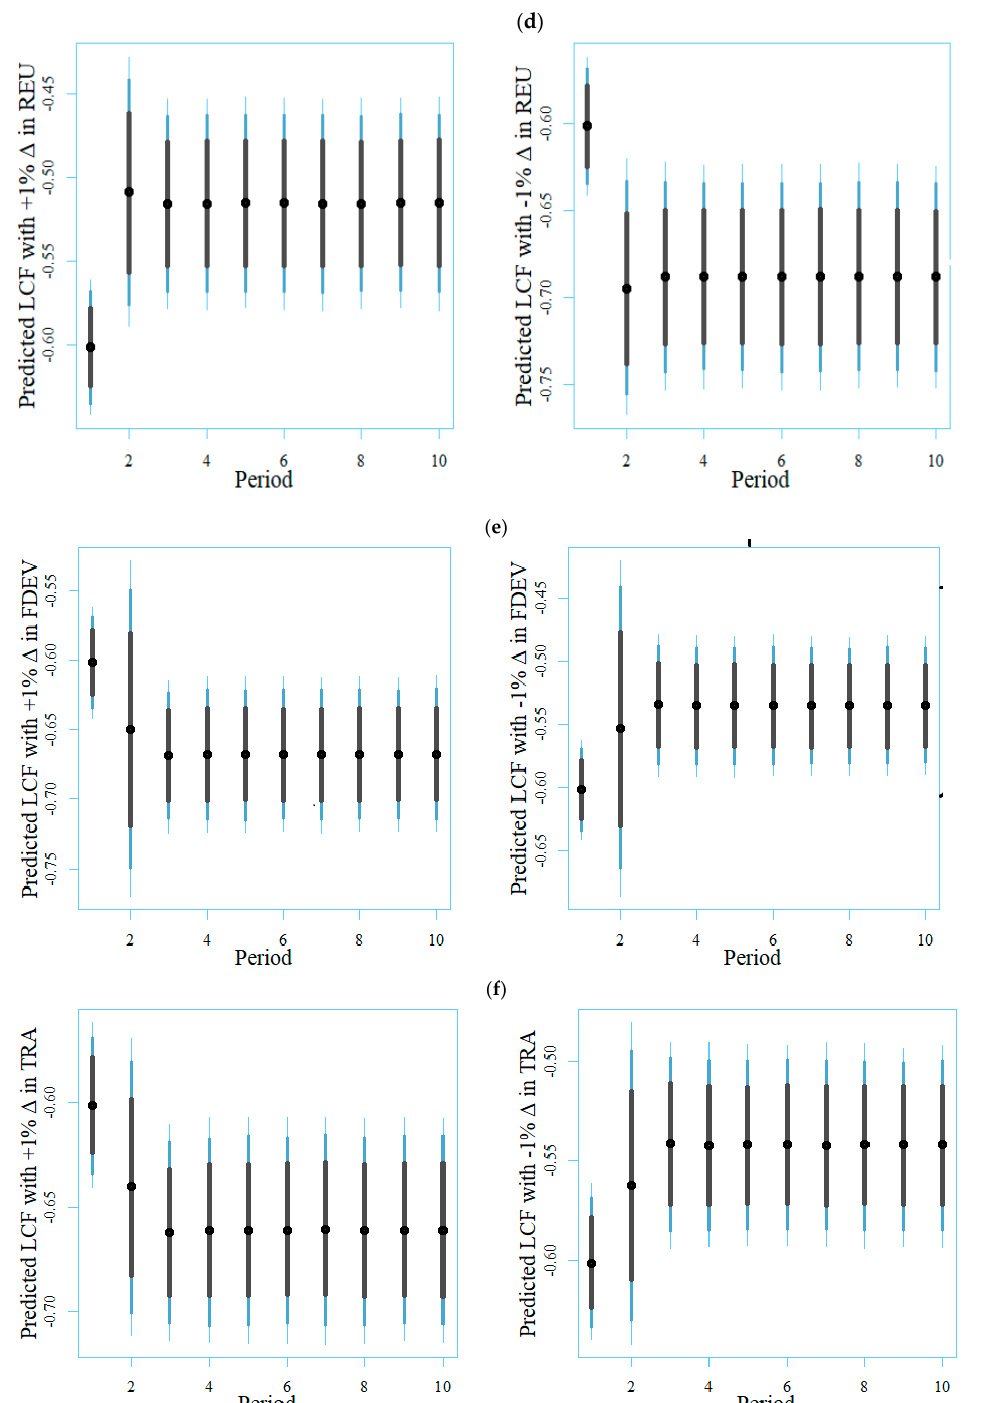
Figure 3. Response of LCF to impulse of ±1% counterfactual change in independent variables ( a ) Response of LCF to impulse of ±1% counterfactual change in GDP; ( b ) Response of LCF to impulse of ±1% counterfactual change in GDPSQ; ( c ) Response of LCF to impulse of ±1% counterfactual change in NREE; ( d ) Response of LCF to impulse of ±1% counterfactual change in REU; ( e ) Response of LCF to impulse of ±1% counterfactual change in FDEV; ( f ) Response of LCF to impulse of ±1% counterfactual change in TRA. Dots visualize the predicted mean value of LCF. The vertical lines from grey to light blue indicate the 75%, 90%, and 95% signi fi cance levels, respectively. The number of simulations was set to 10,000.